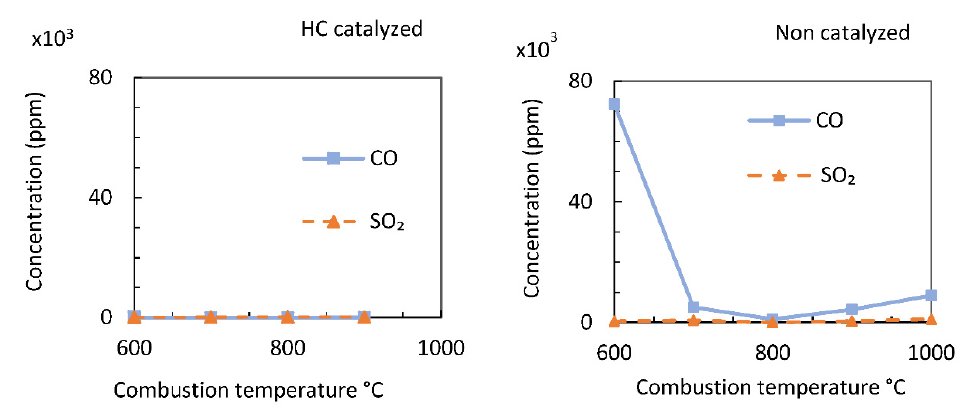
Figure 7. Comparative analysis of SO 2 and CO concentration from a catalytic and non ‐ catalytic combustion of JPN samples. Note: The catalyst was heated at optimal temperature of 427.4 ° C.